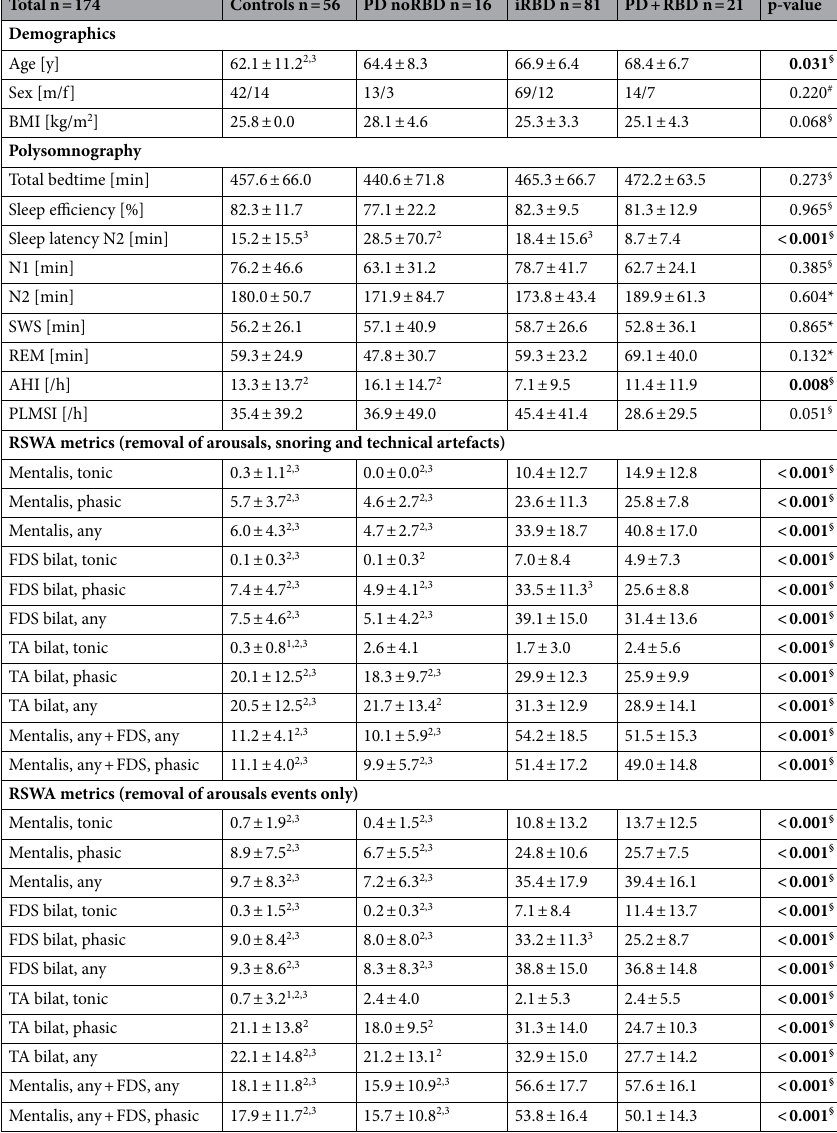
Table 4. Demographics, polysomnography data, and RSWA metrics of subjects evaluated by RBDtector . BMI body mass index, N1/2 non-rapid eye movement sleep stage 1/2, SWS slow wave sleep, REM rapid eye movement sleep, AHI apnoea hypopnea index, PLMSI periodic limb movements in sleep index. Statistics: *ANOVA, § Kruskal Wallis test (post-hoc testing with Mann Whitney U test: 1 different to PD noRBD, 2 different to iRBD, 3 different to PD + RBD at p < 0.05 uncorrected), # Chi square test. Significant values are in